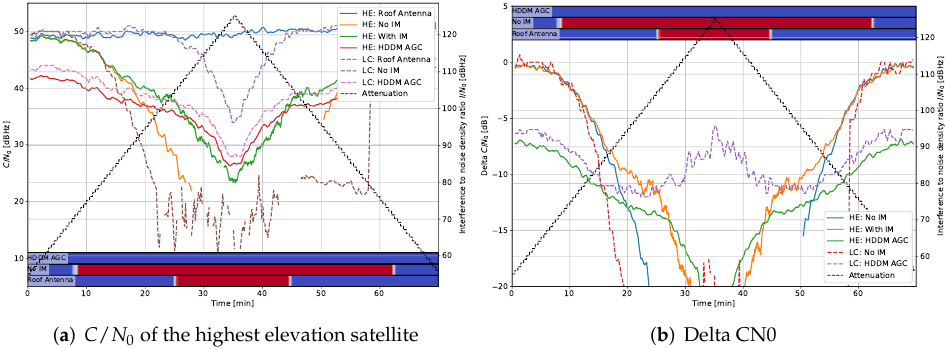
Figure A18. Interference #9: Filtered pulsed noise with 35MHz bandwidth, 50% duty cycle, and 100us pulse width with Galileo